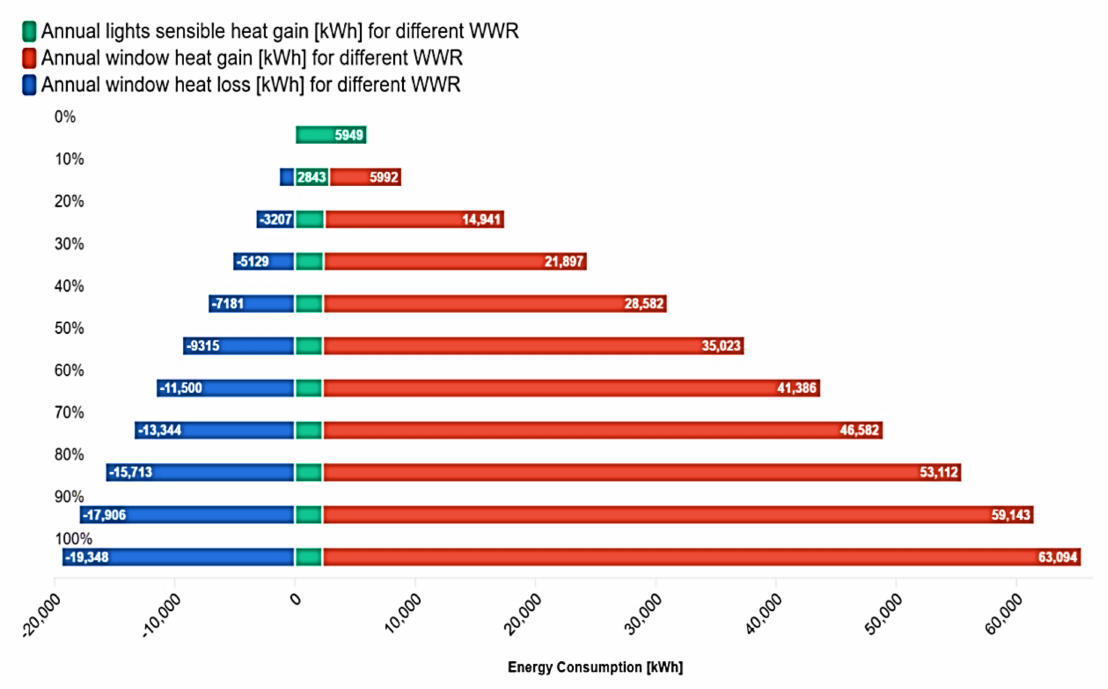
Figure 8. Annual heat gain vs. annual heat loss (kWh) for different